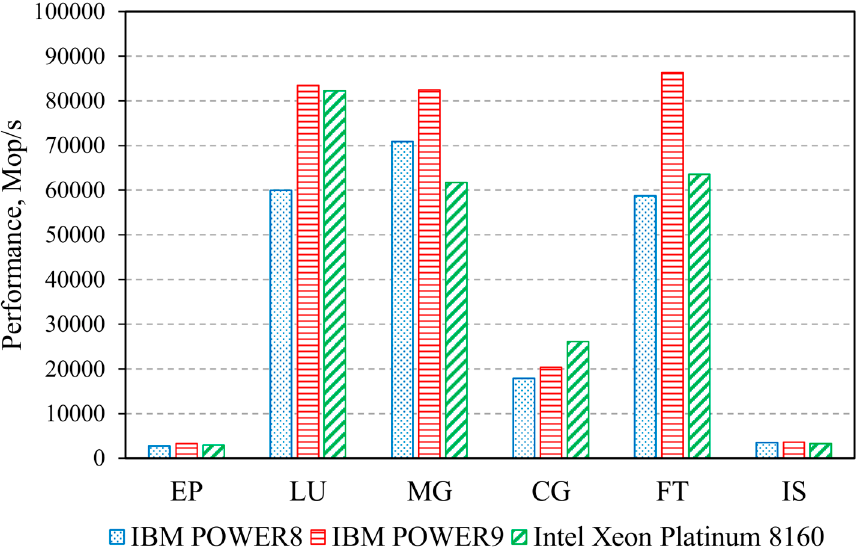
Figure 10. Maximum performance of computing systems in the NPB (Problem Class C).